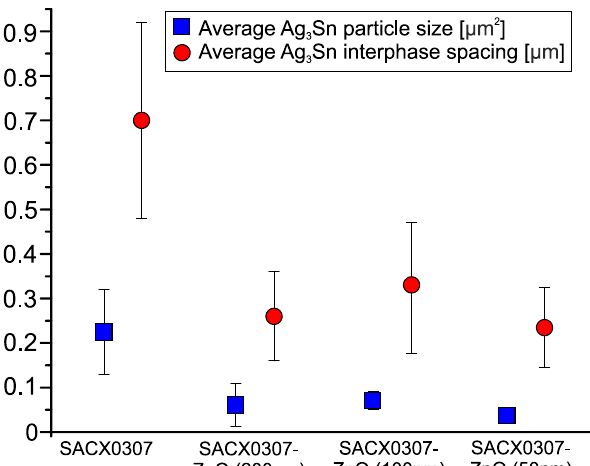
Figure 11. Average Ag 3 Sn particle size and interphase spacing.